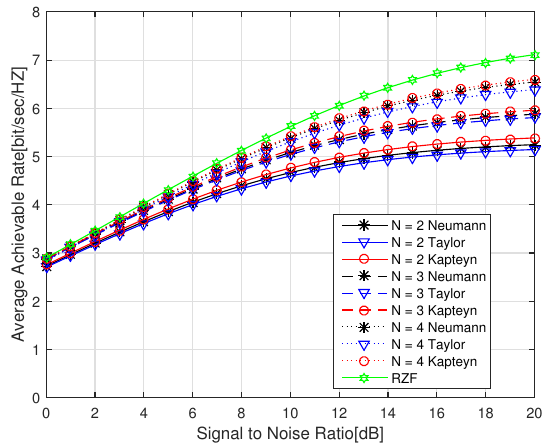
Figure 3. Average achievable rate vs. SINR ( M = 256, K = 32, τ =